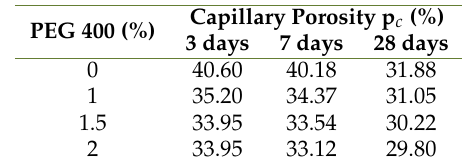
Fig. 7. Total Porosity Values at 0.34 Water-Cement Ratio. Table 7. Capillary Porosity at 0.55 Water-Cement